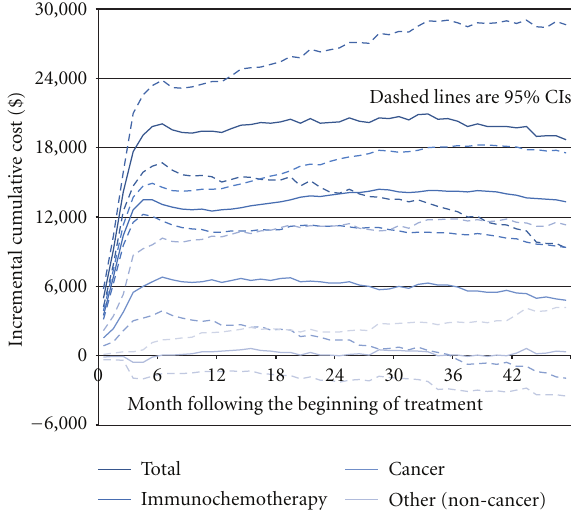
Figure 2: Incremental cumulative cost of adding rituximab to chemotherapy.